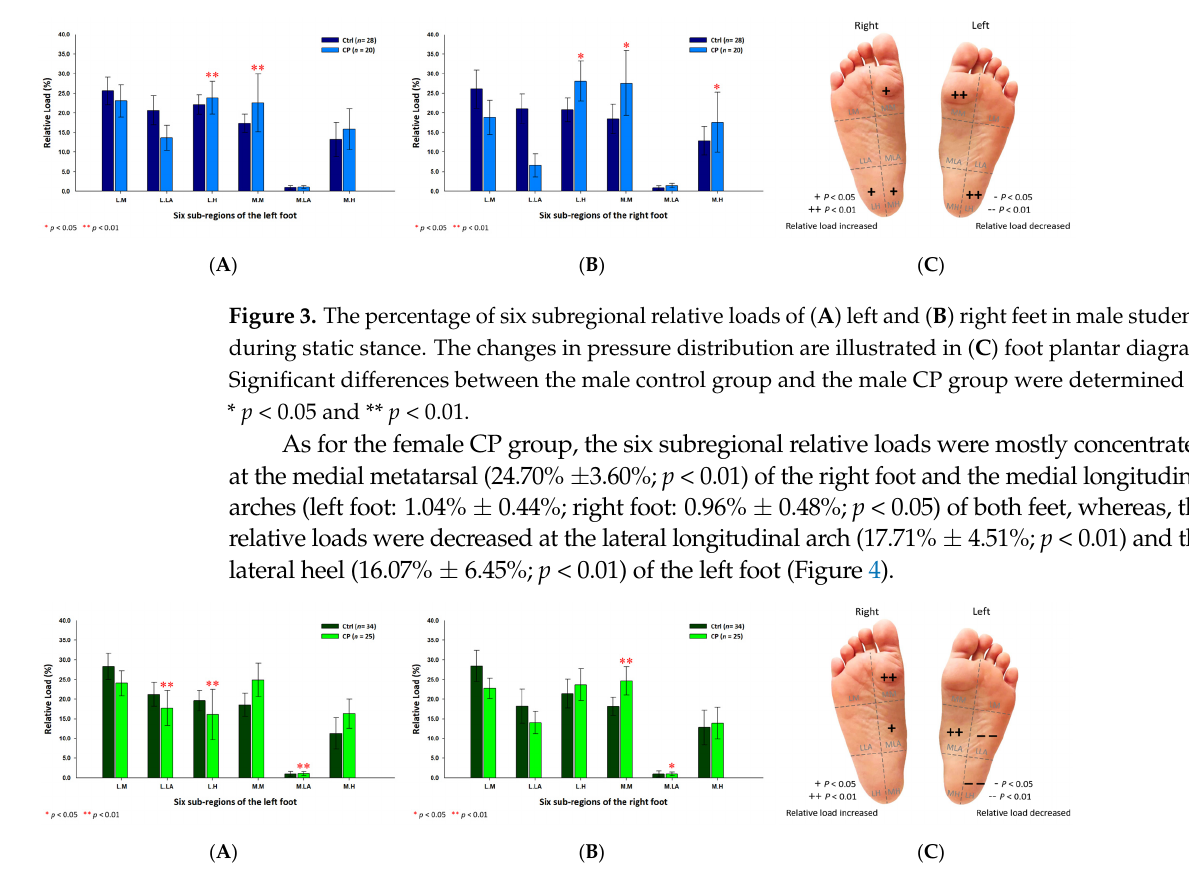
p < 0.05 and ** p < 0.01. Six subregions of the foot and the abbreviations are as follows: LM lateral